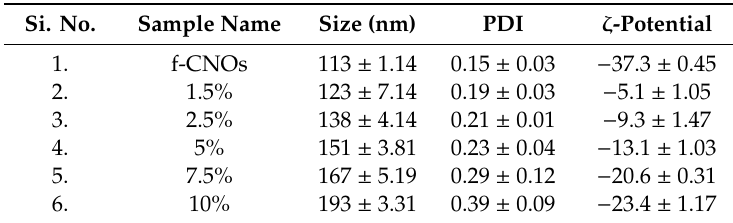
Table 1. The size, PDI, and zeta potential of f-CNOs a